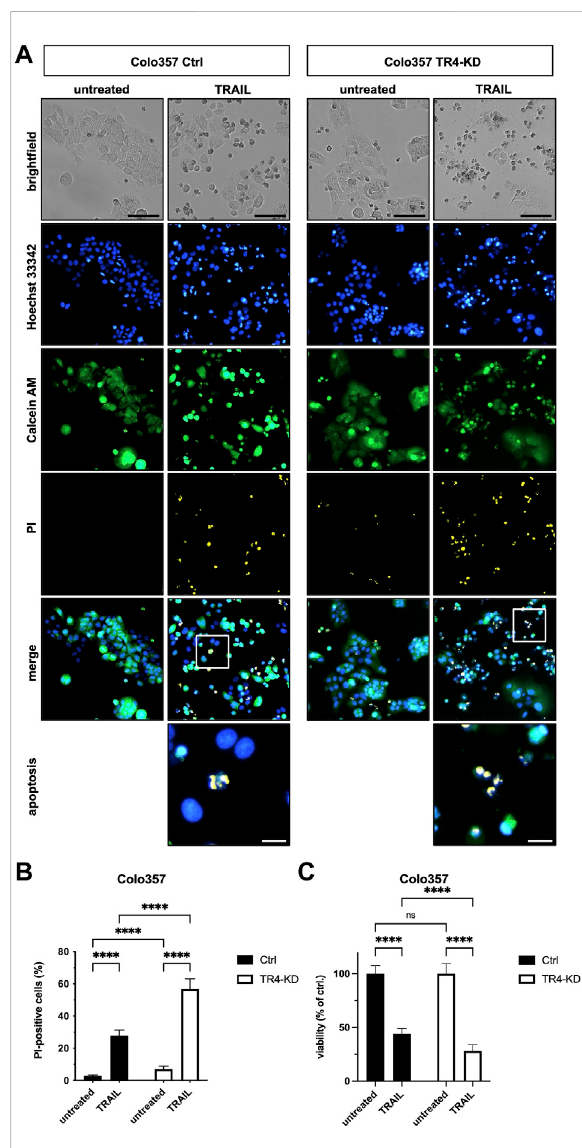
FIGURE 3 Knockdown of TRAIL-R4 increases TRAIL-mediated cell death of Colo357 cells. Colo357 control (Ctrl) and TRAIL-R4- knockdown(TR4-KD) cellswereseeded at1 ×10 4 cells/well in96- well format and 24 hlater stimulated with 50 ng/ml TRAIL for additional 24 h or left untreated. Subsequently, cells were